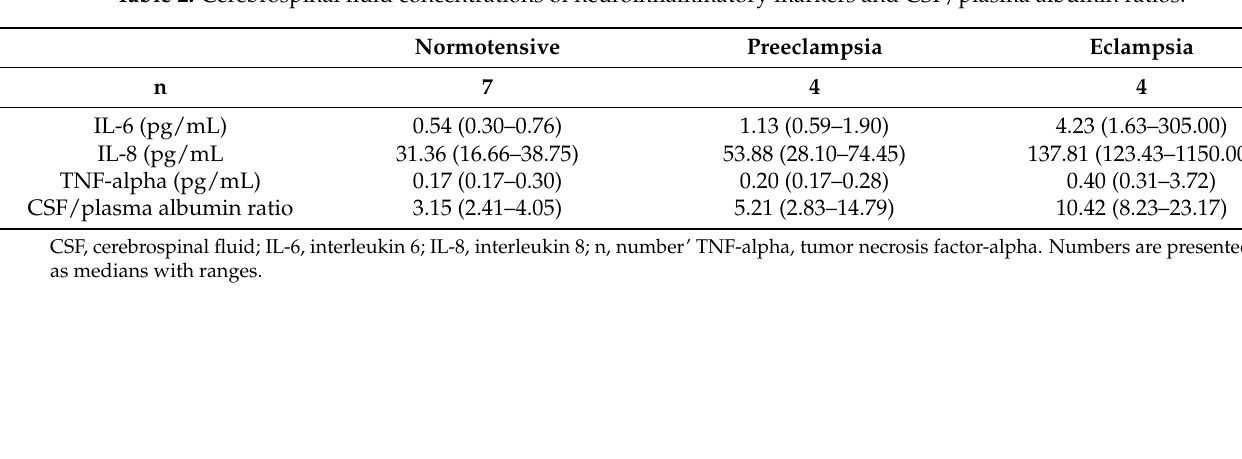
Table 2. Cerebrospinal fluid concentrations of neuroinflammatory markers and CSF/plasma albumin